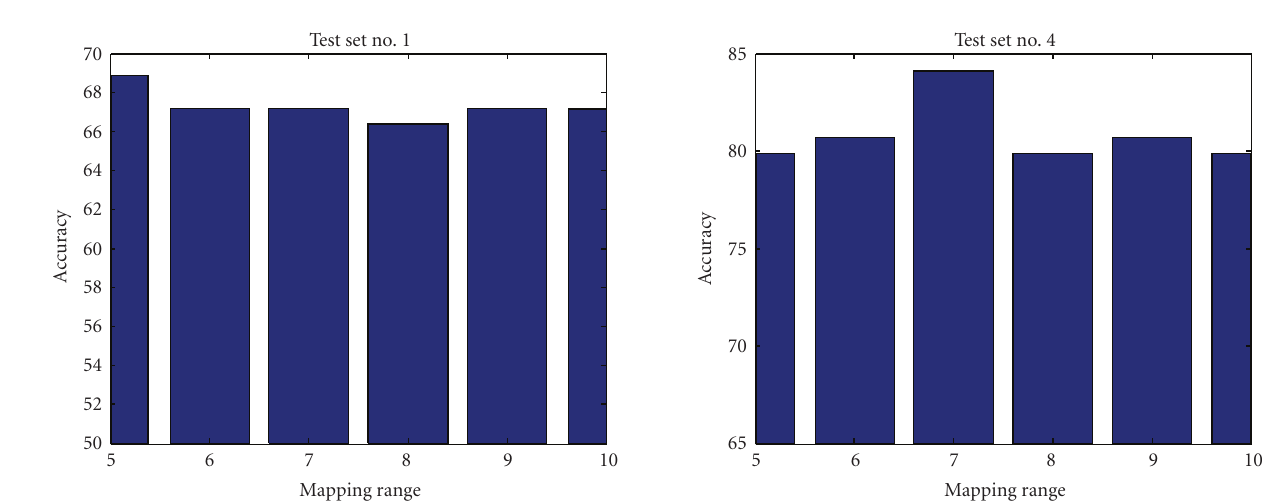
Figure 9: Mapping range impact on accuracy for test set number 1.